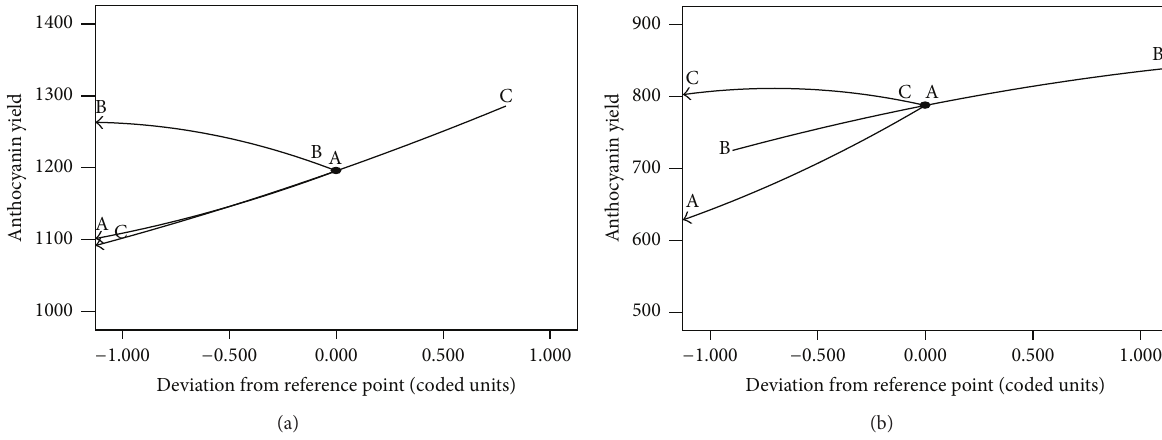
Figure 3: Perturbation plots for (a) methanolic extraction at temperature 60 ∘ C; time 120min; solid to liquid ratio 23.1g/mL and (b) ethanolic extraction at temperature 60 ∘ C; time 86.89 min; solid to liquid ratio 35g/mL.